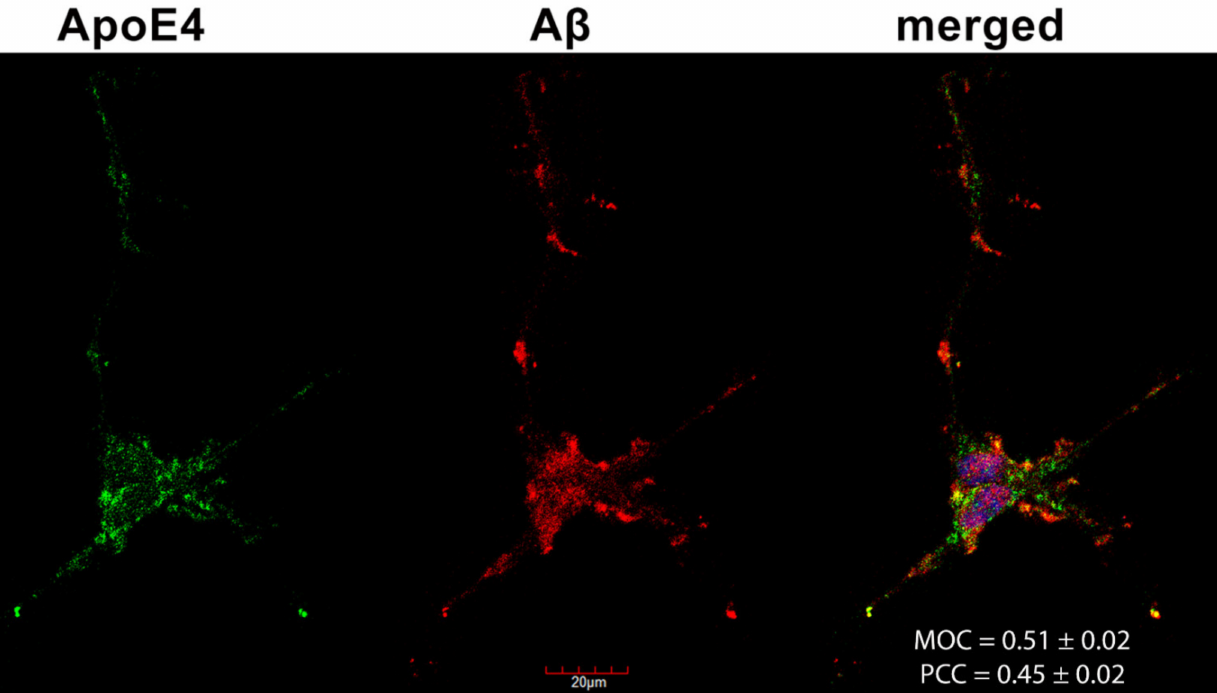
Figure 7. The colocalization of ApoE4 and A β 1–42 fibrils. Differentiated SH-SY5Y cells were preincubated with FITC-ApoE4 and then treated with A β 1–42 for 18 h. After incubation, A β 1–42 fibrils were stained with Congo Red (CR), while the nuclei of cells were stained with DAPI. The colocalization of ApoE4 with CR-stained A β 1–42 fibrils was then analyzed with confocal microscopy. Representative images of three independent experiments are shown. Scale bar = 20 µ m. MOC and PCC ± SEM, for the colocalization of ApoE4 with CR-stained A β 1–42 fibrils, was calculated by analyzing 21 images with ~5 cells in each image (from three separate samples). Scale bar = 20 µ